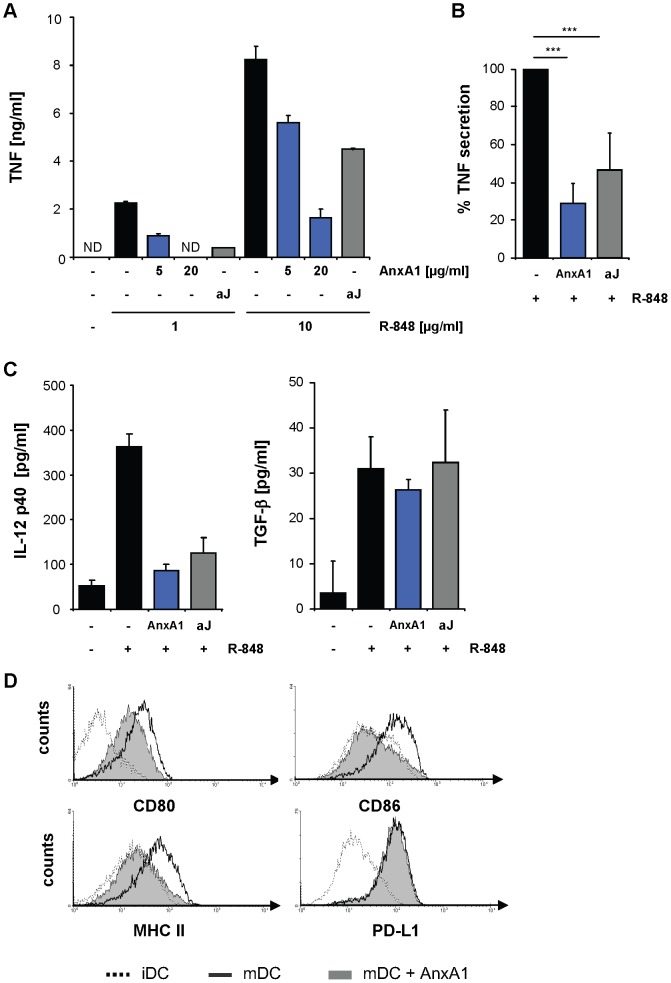
Annexin A1 suppresses DC activation.(A) Immature DC were incubated with the indicated concentrations of annexin A1 (AnxA1) or apoptotic Jurkat T cells (aJ), or left untreated. After stimulation with the indicated concentrations of R-848, TNF in culture supernatants was determined by ELISA. Error bars represent means +/− SD of duplicate cultures. ND = not detectable. (B) DC were treated as in (A). For several donors, the relative TNF secretion of treated DC was calculated relative to DC stimulated with R-848 only, which was set to 100%. Error bars represent means +/− SD (n = 7). ***P<0.001. (C) Secretion of IL-12 p40 and TGF-β from DC treated as in (A). Error bars represent means +/− SD of triplicate cultures. ND = not detectable. (D) Analysis of DC surface molecules. Untreated DC (iDC, dashed line) or DC stimulated by a cytokine cocktail after pre-incubation with annexin A1 (mDC+AnxA1, filled histograms) or without annexin A1 (mDC, bold lines) were analyzed by flow cytometry for the indicated molecules. Data are representative of at least 3 independent experiments. In experiments B to D, recombinant annexin A1 was used at a concentration of 5 or 10 µg/ml while R-848 was used at a concentration of 5 µg/ml.